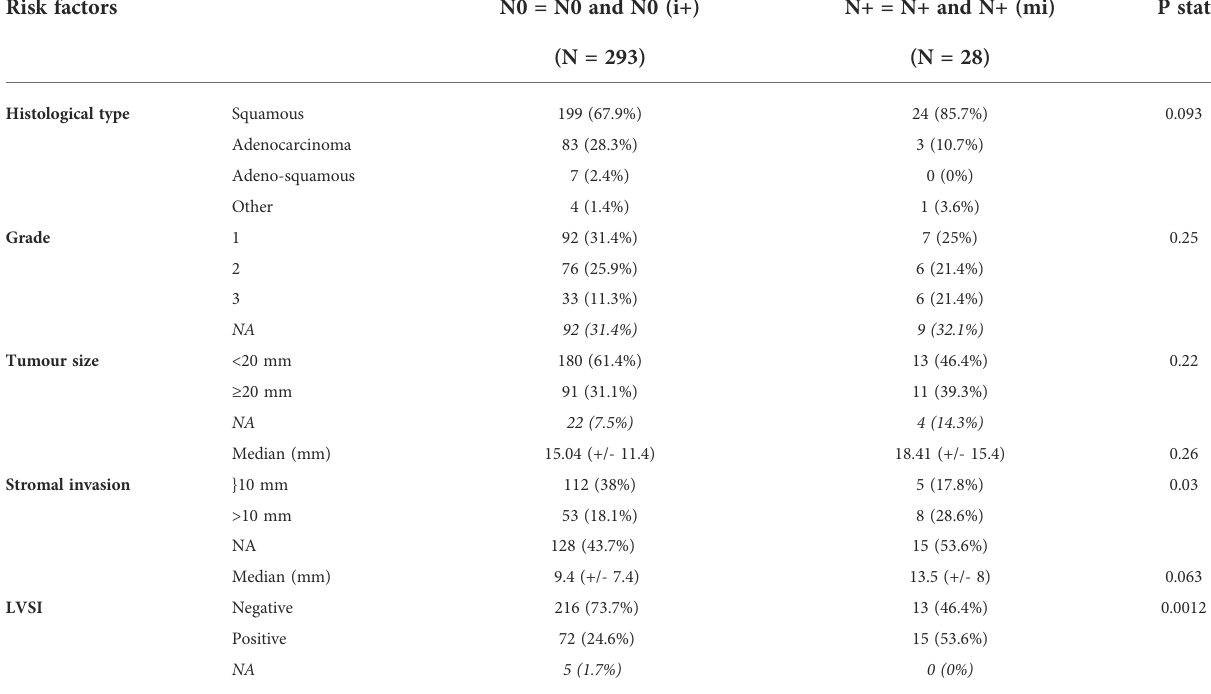
TABLE 1 Characteristics of Senticol 1 and 2